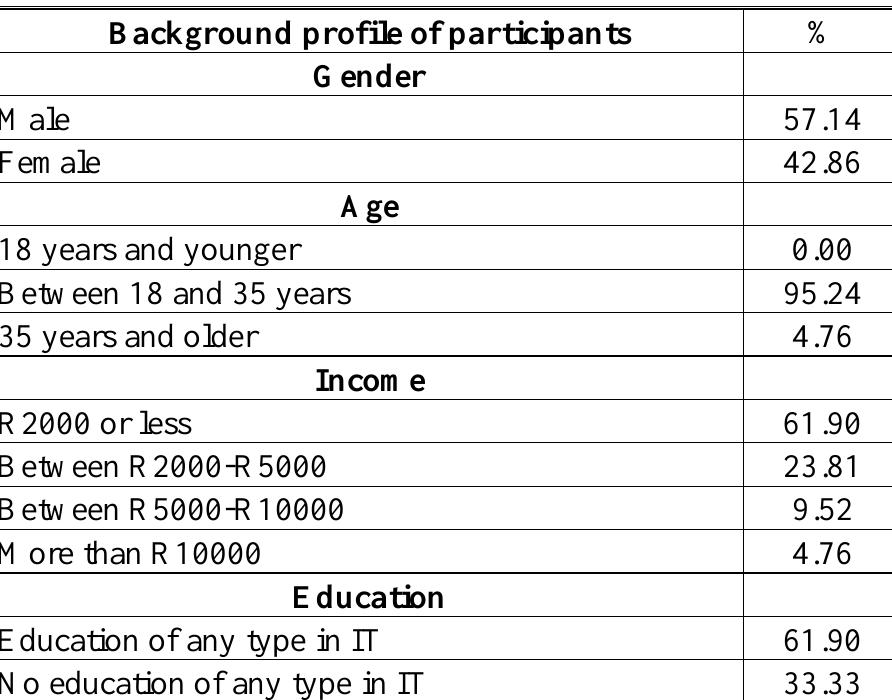
Background profile Background profile of